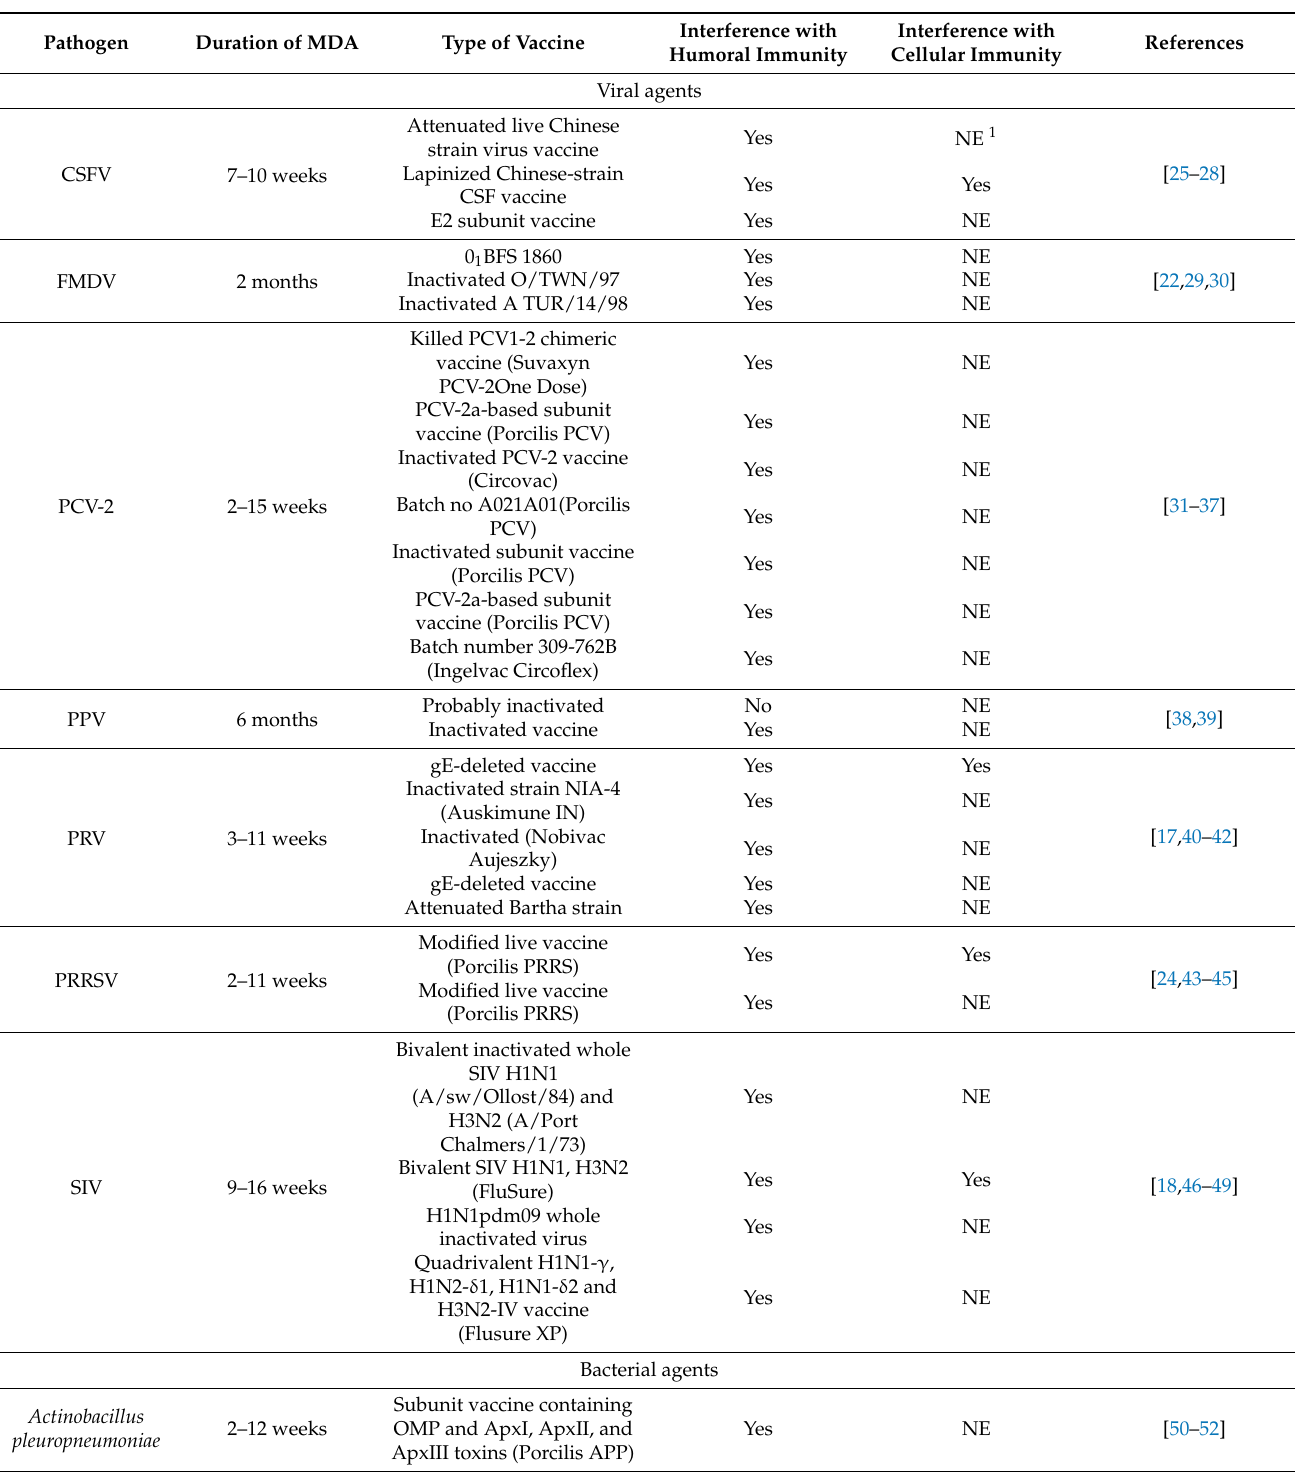
Table 1. Duration of MDAs against various pathogens and their influence on the vaccine-induced immune